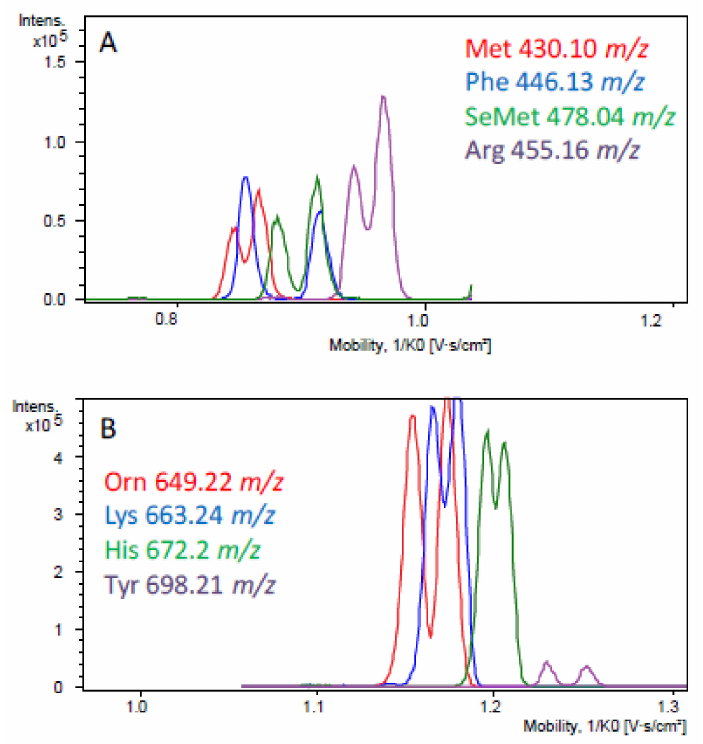
Figure 8. TIMS-TOFMS of FLEC-AA mixtures using a voltage ramp of ( A ) 109–135 V and ( B ) 135–170 V in 510 ms. Reproduced with permission from the authors of